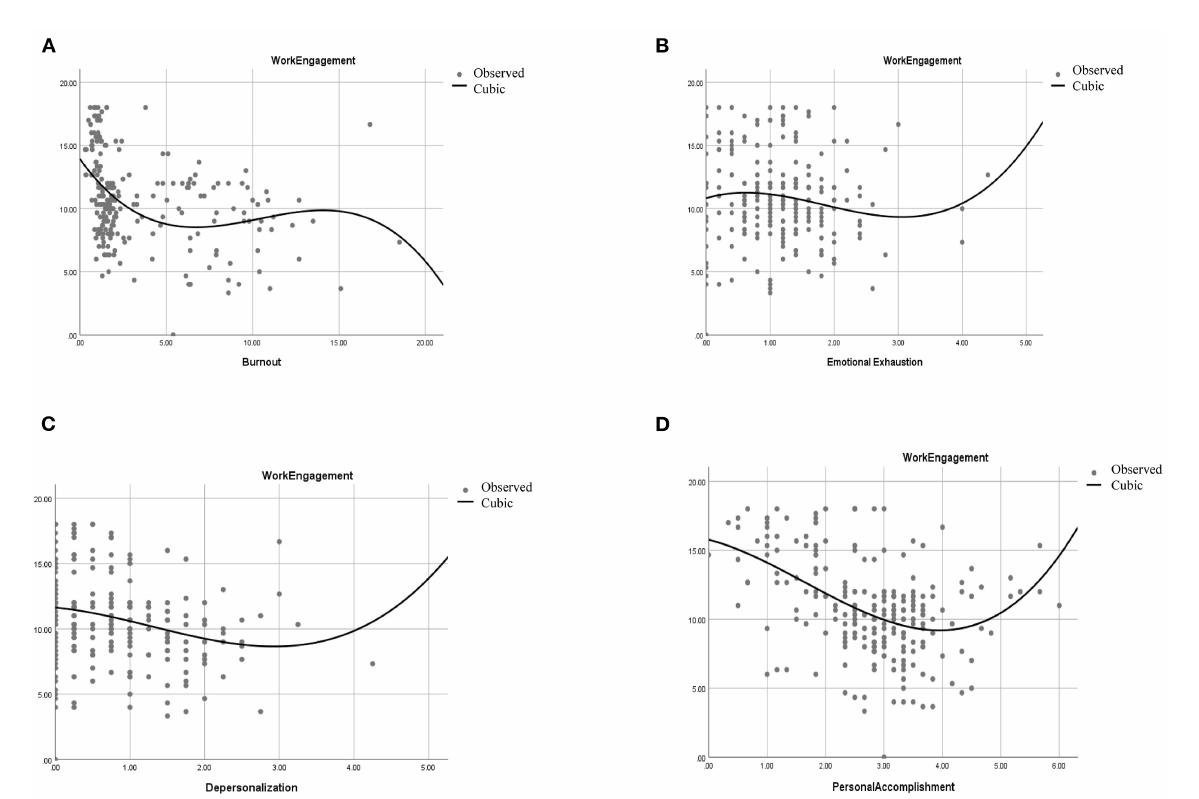
FIGURE2 Curvilinear relationships. (A) Curve relationships between work engagement and burnout. (B) Curve relationship between work engagement and emotional exhaustion. (C) Curve relationship between work engagement and depersonalization. (D) Curve relationship between work engagement and personal